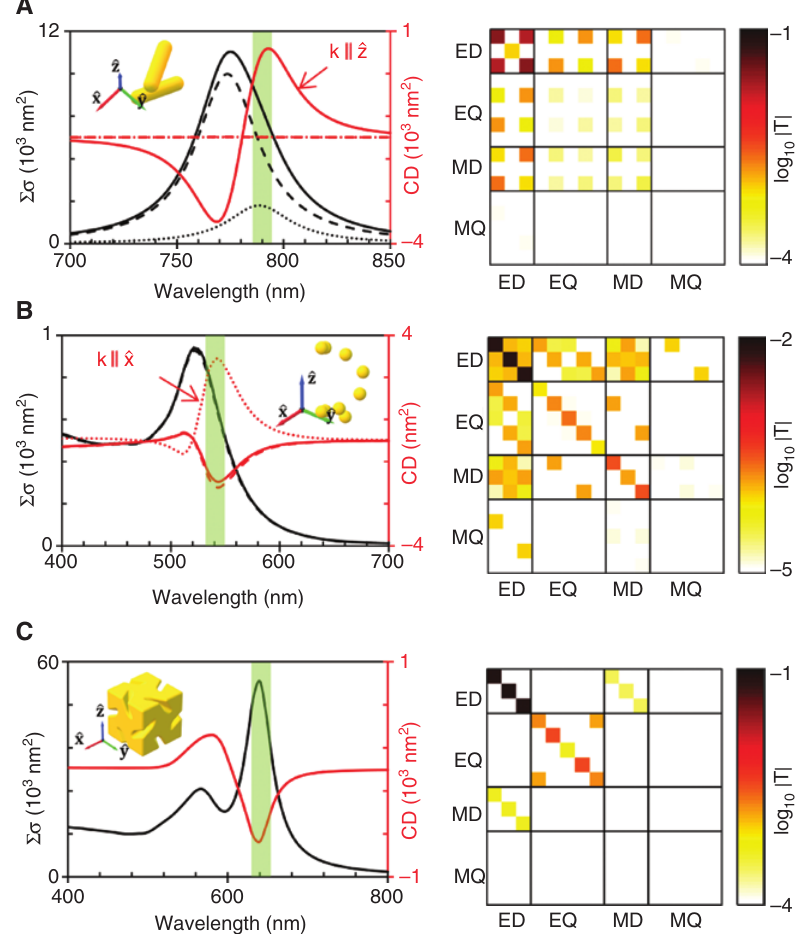
Figure 4: Subwavelength plasmonic chiral scatterers with a higher-order transition. (A–C) Geometrical representation (inset), extinction ( Σ σ ) and CD (left) of (A) twisted nanorods, (B) helical assembly, and (C) cNP, and their T-matrix (right) at (A) 790 nm, (B) 540 nm, and (C) 640 nm. Σ σ (black) and CD (red) at (cid:31) ˆ k x (dashed), (cid:31) ˆ k y (dot-dashed), and (cid:31) ˆ k z (solid). Geometric parameters are: (A) twisted-nanorods with 5-nm radius, 25-nm gap, 38-nm length, and 50 ° twist angle; (B) helical assembly with 17-nm major radius, 5-nm minor radius, 56-nm pitch, and 1.5-turn; (C) cNP with 50-nm edge length, 5-nm gap width, 20-nm gap depth, and 60 ° gap angle. The optical parameters of the Au particles are taken from